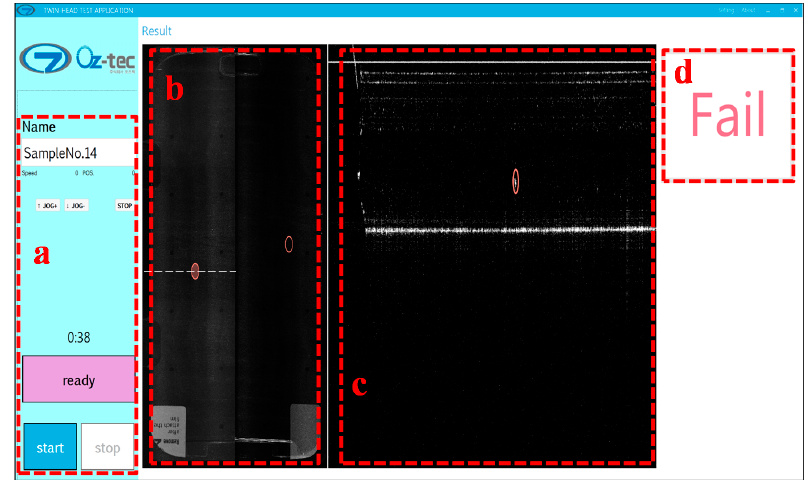
Figure 6. Optical thin film panel enface image with real-time fault detection: ( a ) system setup containing user control buttons and indications; ( b ) enface image of sample obtained from two scanning heads; ( c ) cross-sectional OCT image with fault detection in panel along white dashed line in ( b ); and ( d ) “Pass” or “Fail” indication based on fault detection.